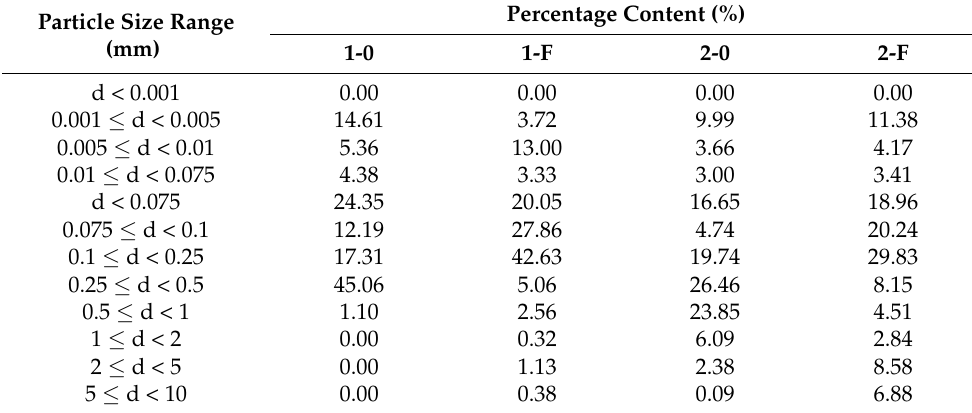
Table 4. Particle size